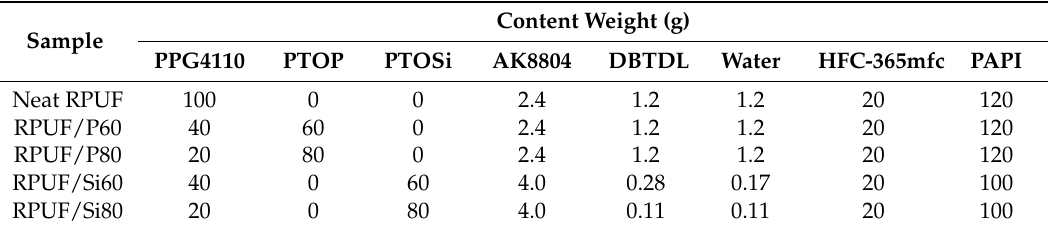
Table 2. Formulation of rigid polyurethane foam